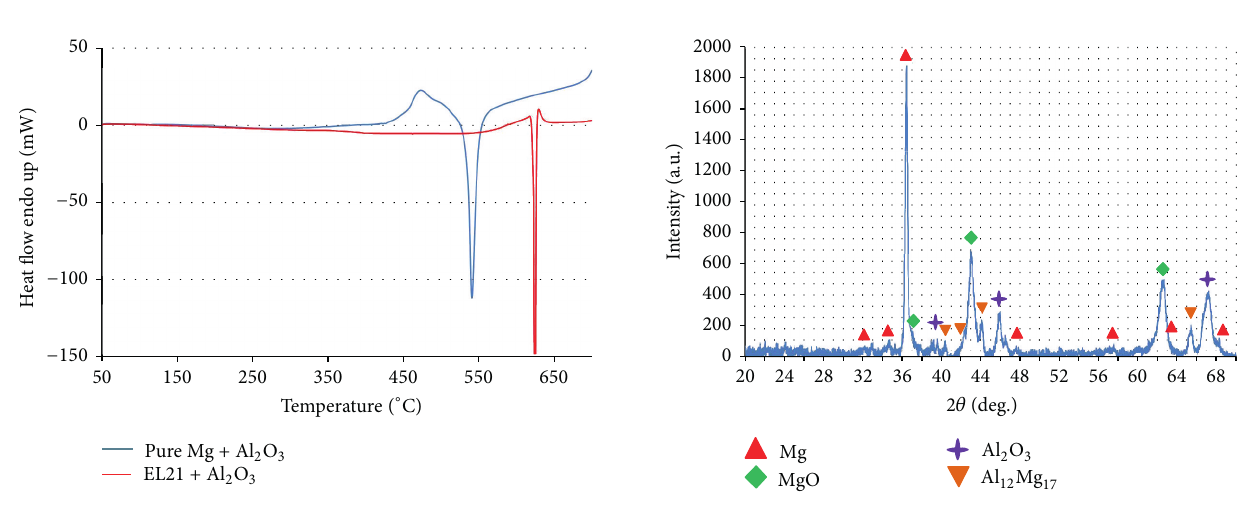
Figure 4: DSC of the reaction of pure Mg (blue) and Elektron 21 (red) with Al 2 O 3 .